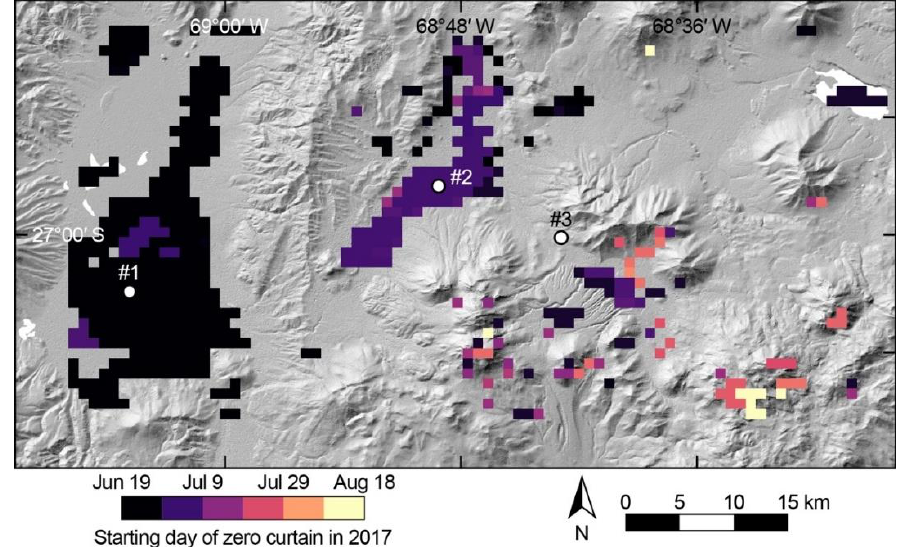
Figure 7. The starting day of the zero curtain, determined using the Threshold Window algorithm, during the thaw season of 2017.